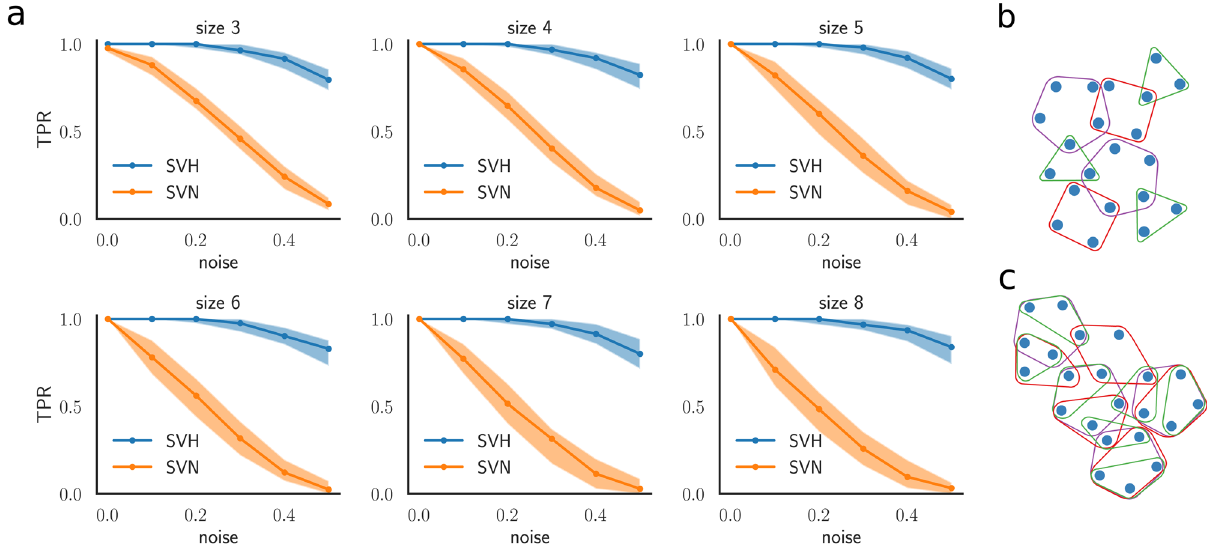
Fig. 2 Hypergraph benchmark and performance analysis. a Numerical simulations of the benchmark characterized by the presence of hyperlinks of size n ranging from 3 to 8. Median of the true positive rate of the detected hyperlinks obtained by using the Statistically Validated Hypergraph (SVH) methodology (blue line) and the detection of the pairwise overexpression in the Statistically Validated Network (SVN) (orange line) as a function of the noise parameter. The shaded area around the lines represents the interval between 10th and 90th percentile observed in 1000 realizations. Each panel is related to hyperlinks of different sizes n . b Benchmark realization with 22 nodes and fraction f = 0.4. The sizes of hyperlinks are 3 (green lines), 4 (red lines), and 5 (purple lines). c Benchmark realization with 22 nodes and f =